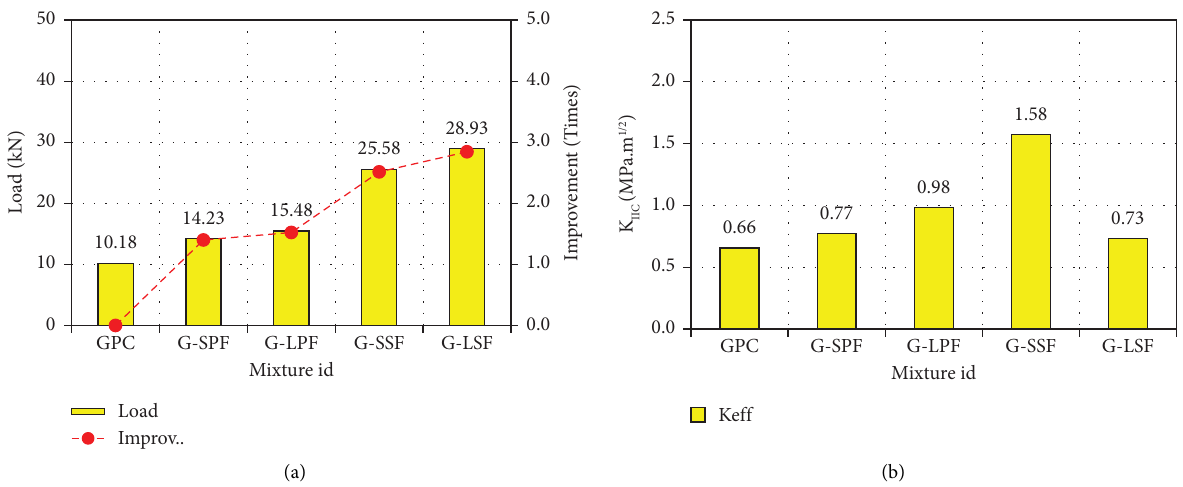
Figure 11: Mixed-mode fracture toughness of specimens under 15 ° loading.